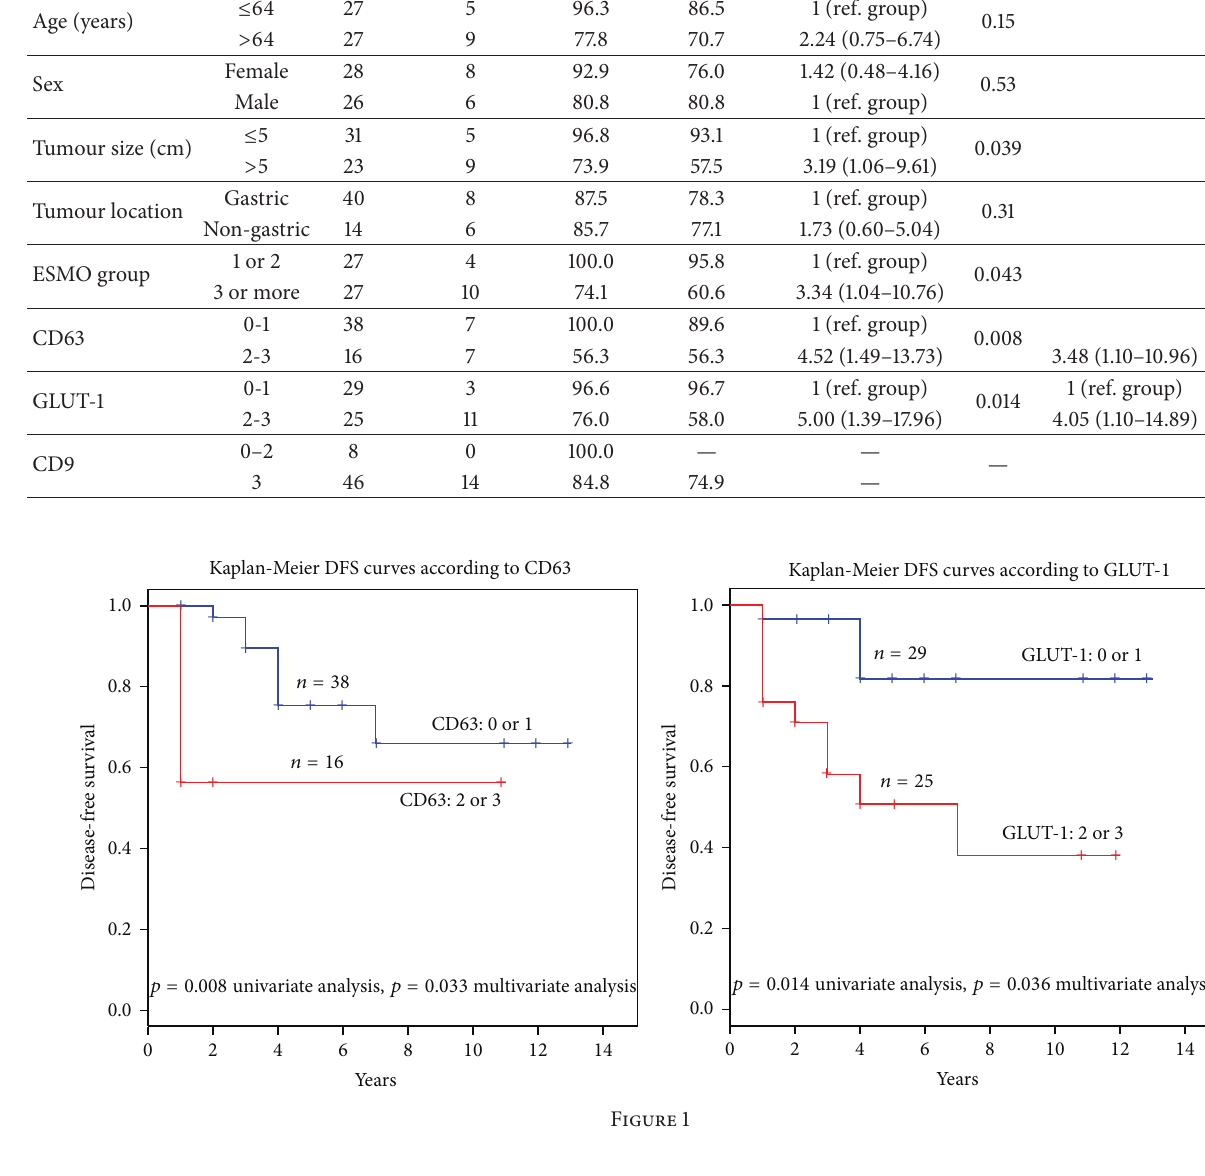
Table 2: Univariate and multivariate Cox regression model for the recurrence of GIST.